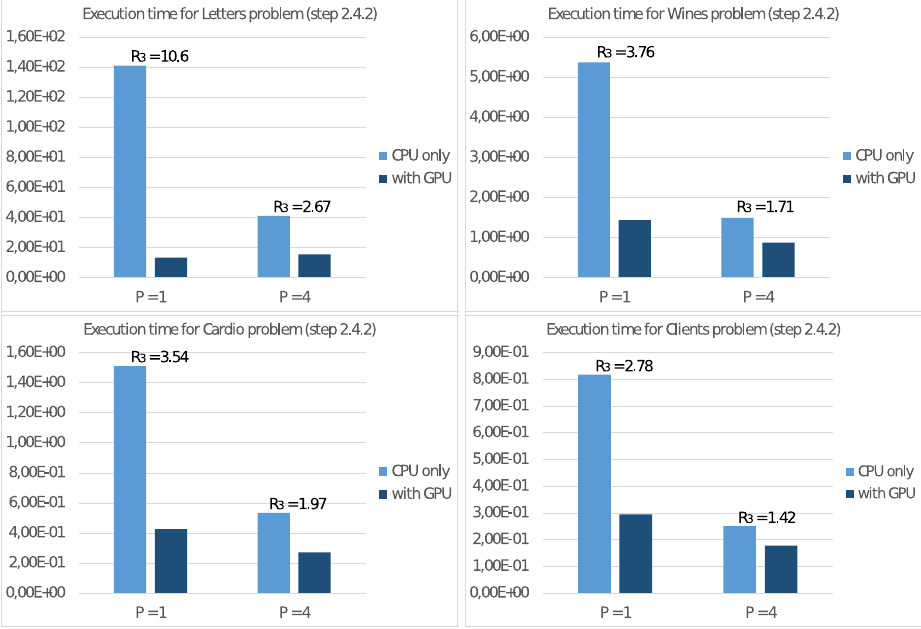
Figure 9. Execution time (in seconds) of step 2.4.2 of Algorithm 2 on the NVIDIA Jetson Nano board and performance gains R 3 obtained through GPU